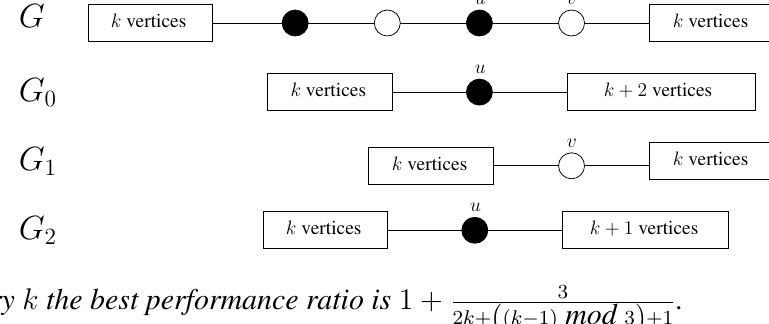
Figure 6 . A local algorithm A with locality distance k has to take the same decisions for the vertices u and v in G , G , G , and G . The black vertices show a possible dominating set computed by A . In order 1 2 3 to simplify this figure the rectangular boxes represent k , k + 1 , or k + 2 vertices on the line, respectively.